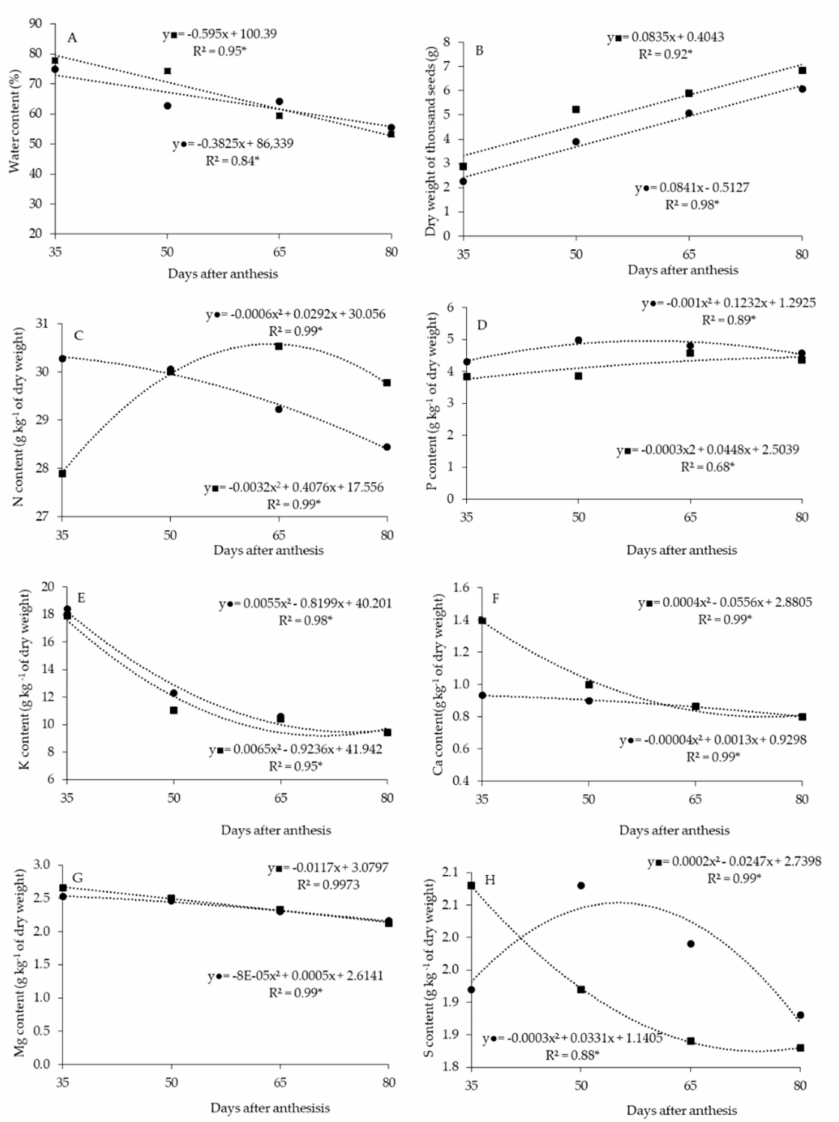
Figure 1. Seed water content ( A ), dry weight of one thousand seeds ( B ), nitrogen—N ( C ), phosphorus—P ( D ), potassium—K ( E ), calcium—Ca ( F ), magnesium—Mg ( G ) and sulfur—S ( H ) con- tent in sweet pepper seeds, as a function of maturation stage, without ( • ) and with ( (cid:4) ) post-harvest resting of fruits. * significant difference at 5%